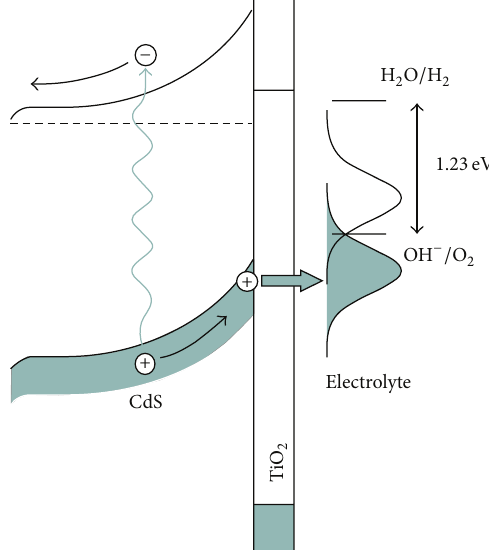
Figure 1: Band diagram of a TiO 2 -coated CdS photoanode, illus- trating the possibility of hole transfer by tunneling if the TiO 2 film is sufficiently thin. The redox couple’s distribution of states in the electrolyte is indicated in this figure as well.